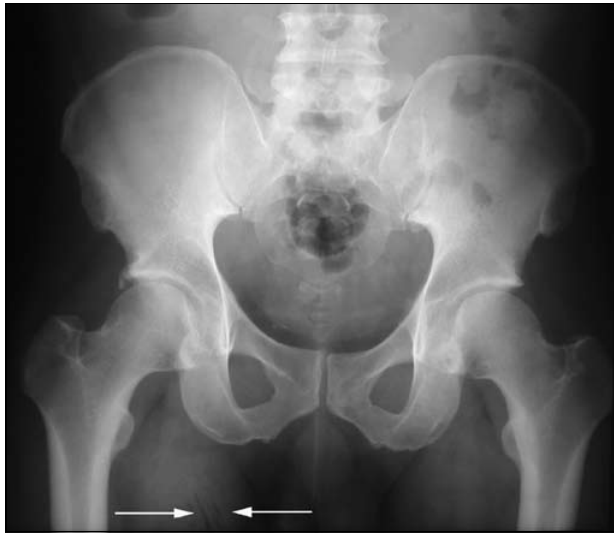
Fig. 2b. Teflon felt not visible in pelvic X-ray; note air lucencies in right medial thigh (arrows).